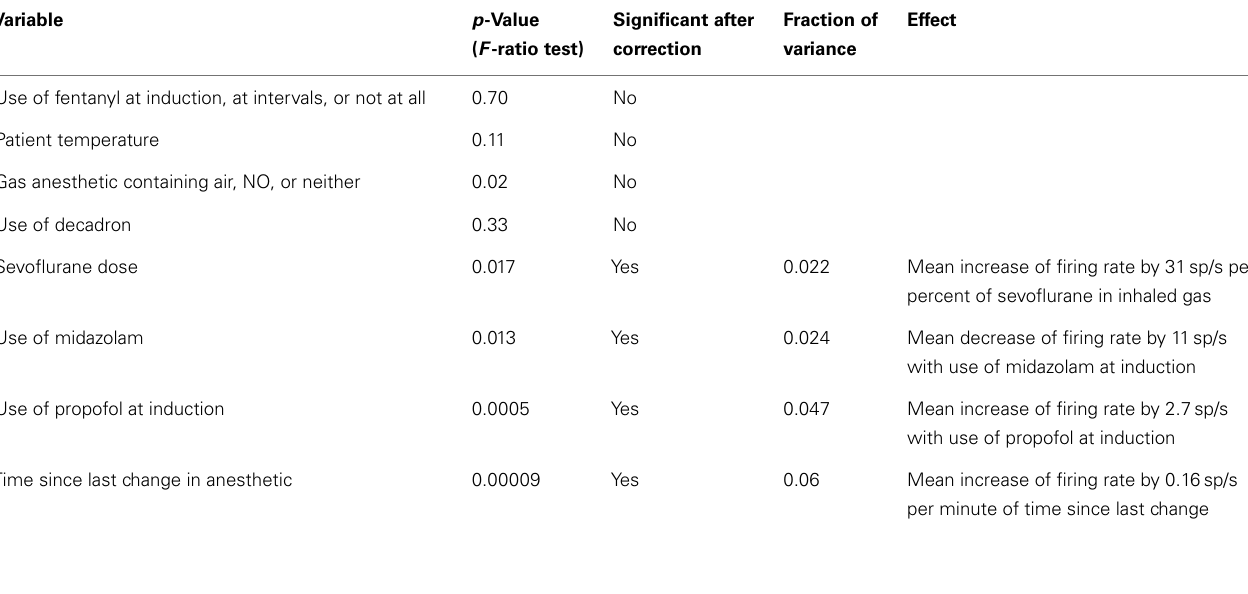
Table 2 | Effects of anesthesia on neuronal firing